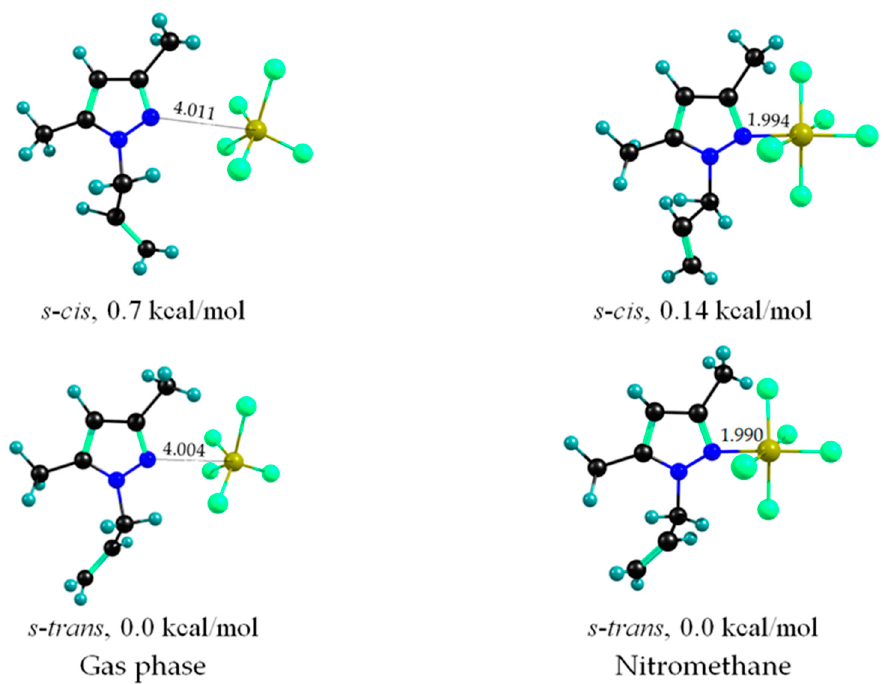
Figure 4. Predominant conformations of the complex of 1-allyl-3,5-dimethylpyrazole with PCl 5 32 calculated by the B3LYP/6-311G(d,p) method, and their relative energies. Solvent (nitromethane) effect was taken into account within the PCM. Interatomic distances are given in Å. The calculated 31 P NMR chemical shifts of complex 28 both in the gas phase and in solution are in good agreement with the experimental values (see Table 10). Deviations do not exceed 12 ppm, which may indicate the complexation of vinylimidazole with phosphorus pentachloride. The theoretical conformational analysis data also evidence the generation of an N → P bond, because the distance between the pyridine nitrogen atom and the phosphorus atom is not higher than 2 Å, and the configuration of the phosphorus atom is modified to be octahedral, which is typical for sp 3 d 2 hybridization. It should also be noted that consideration of the solvent effect in the geometry optimization leads to a shortening of the P – N distance in both conformers 28 by about 0.1 Å, which eventually favors more appropriate calculation of the 31 P chemical shift. Table 10. Experimental and theoretical values of 31 P NMR chemical shifts of phosphines 5 and 37 – 39 calculated by the GIAO-B3LYP-ZORA/DZP method.